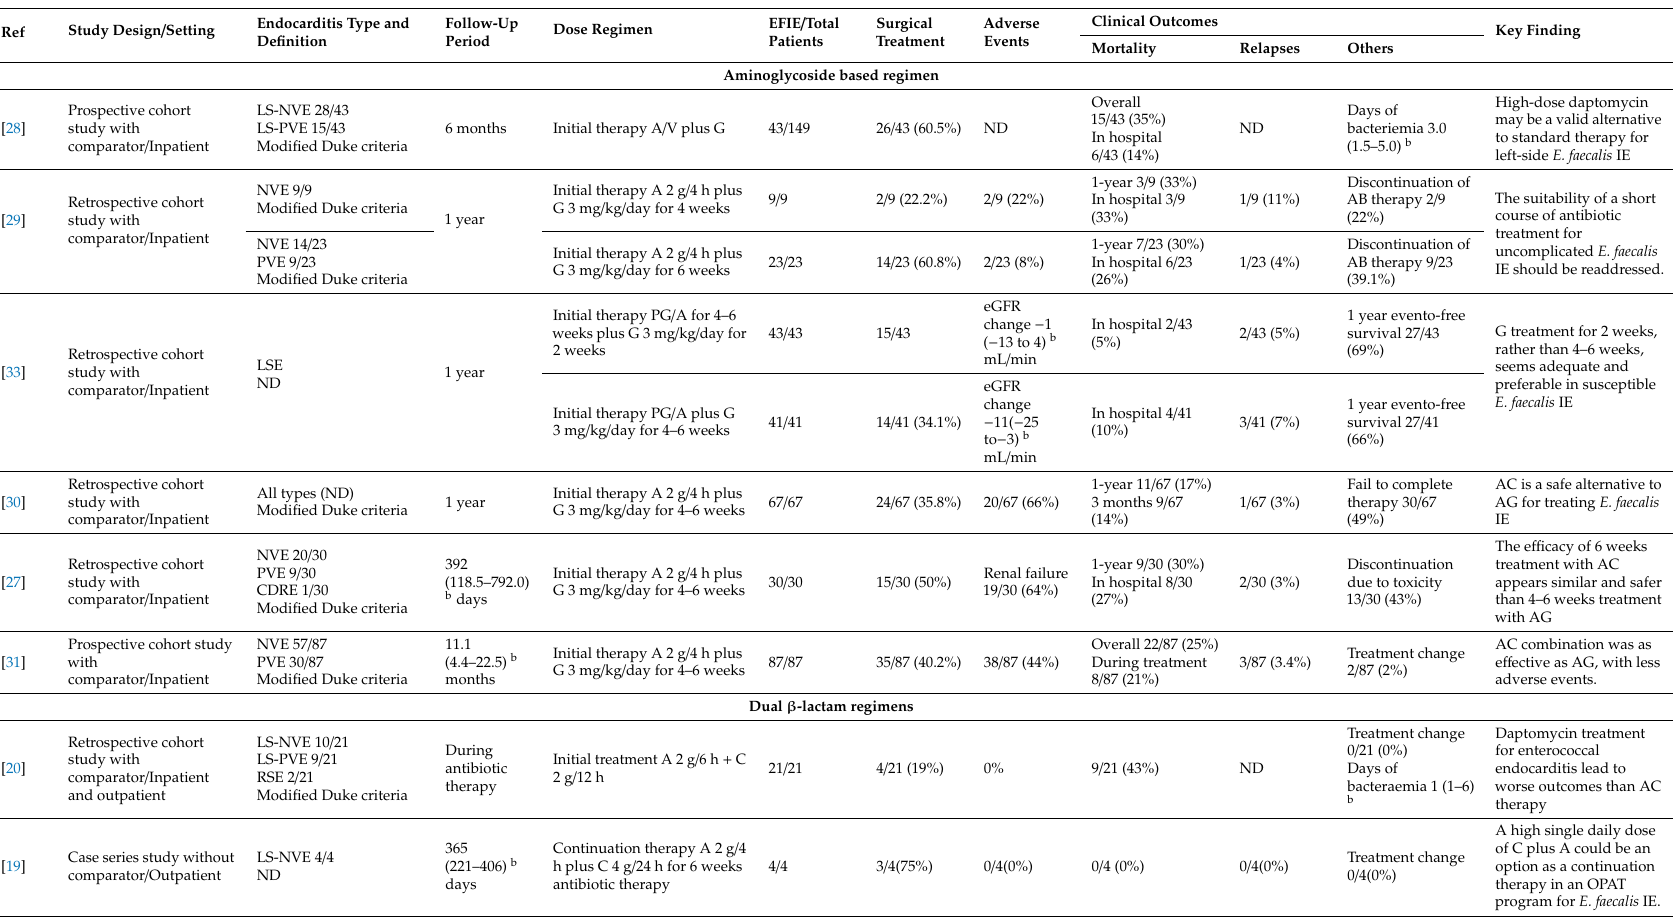
Table 1. Summary of the